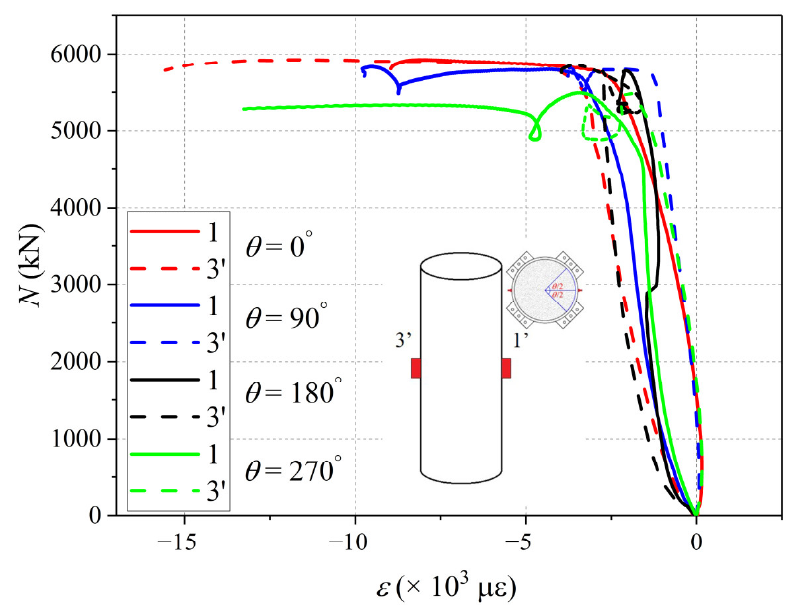
Figure 13. The N - ε l curves of cross-section at a 1/2 height of the BWCFST specimens with interfacial gap with different θ .